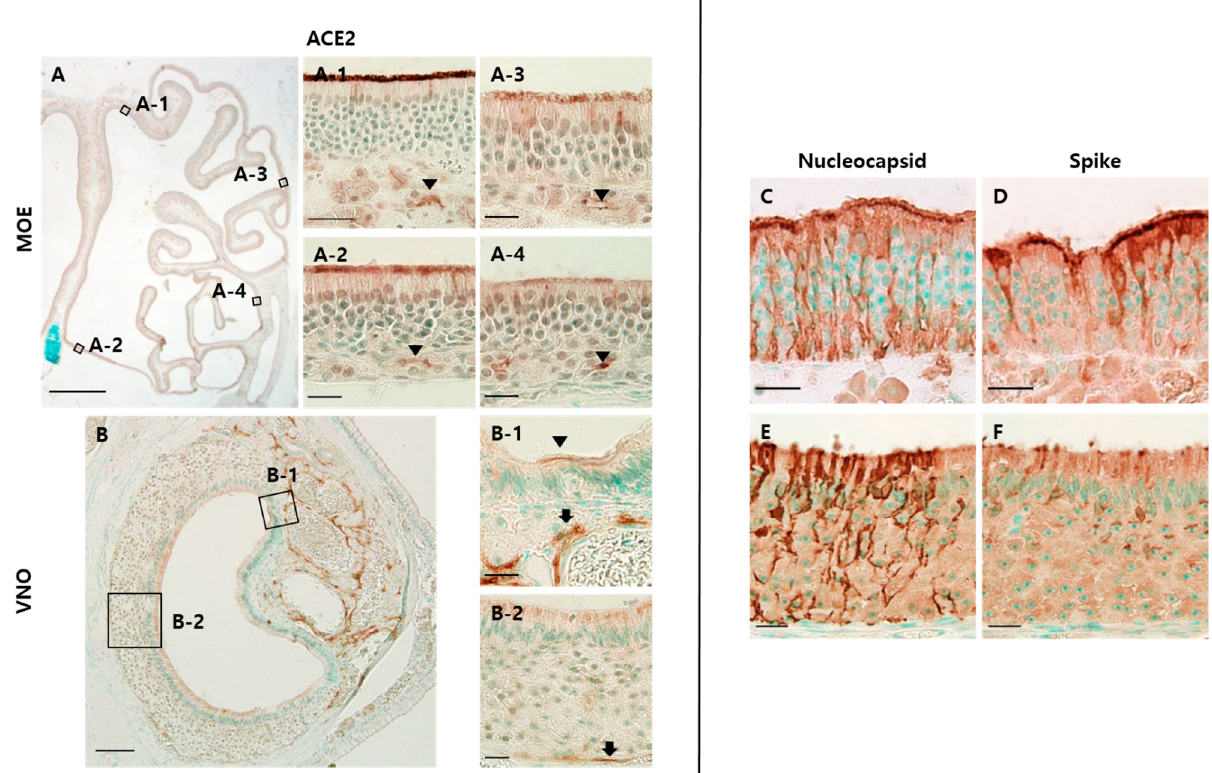
Figure 2. SARS-CoV-2 infections in the olfactory system. The scale bar in ( A ) is 1 mm, in ( D ) is 100 μ m, and in all others is 20 μ m. ( A ) DAB staining with the antibody to ACE2 in dorsomedial ( A-1 ), ventromedial ( A-2 ), dorsolateral ( A-3 ), and ventrolateral ( A-4 ) MOE of the mock group: ACE2 was expressed on the apical surface of the epithelium and luminal surface of Bowman’s glands (arrowhead). In the lateral region, ACE2 expression on the apical surface becomes weak and sparse; ( B ) DAB staining with the antibody to ACE2 in the non-sensory epithelium (NSE) and VSE: ACE2 was expressed on some of the apical surface of NSE and cavernous tissues ( B-1 ). ACE2 expression was also observed in the apical portion of the VSE, intraepithelial capillaries, and blood vessel walls just below the epithelium ( B-2 ); ( C,D ) DAB staining with the antibody to nucleocapsid (N) and spike (S) protein in the MOE of the infected group. Both N and S protein were expressed on the epithelial cells spanning the whole layer of the MOE; ( E,F ) DAB staining with the antibody to N and S protein in VSE. N protein was expressed on the whole height of the VSE, whereas S protein was expressed on the perinuclear region and apical portion of the VSE.